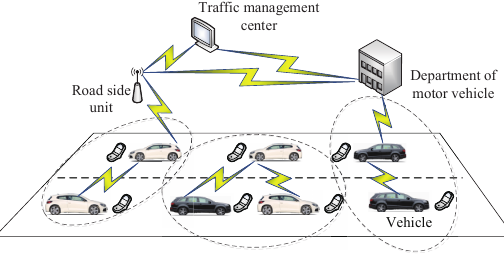
Figure 5. The network model in